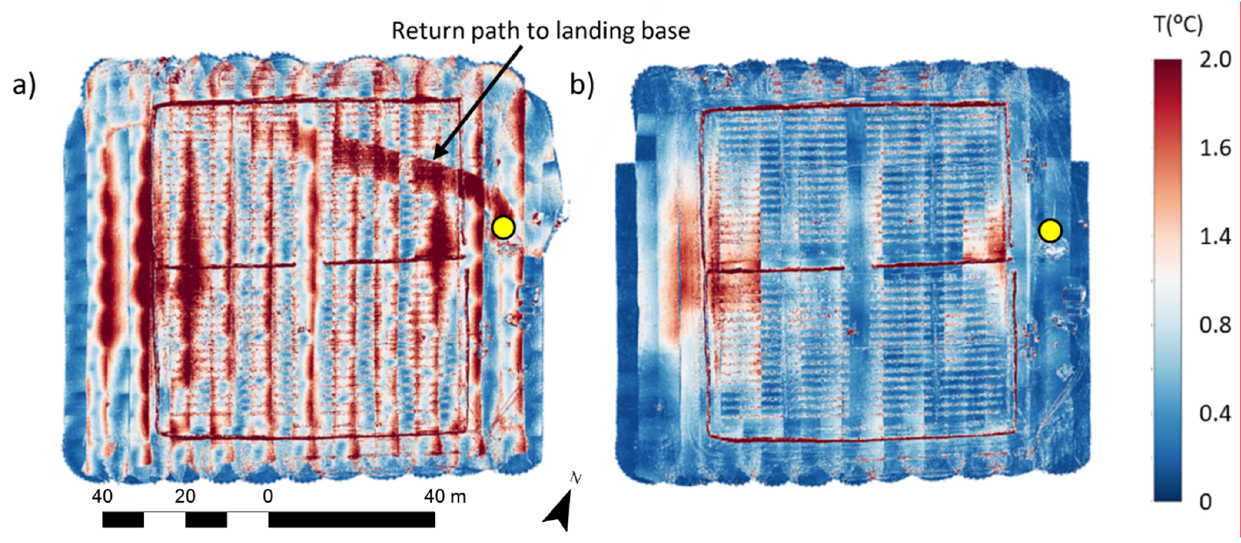
Figure 5. Standard deviation of orthophotos before ( a ) and after ( b ) calibration and vignetting correction for 20 December 2017 at 10:19–10:35. Yellow dot indicates the take-off/landing base.